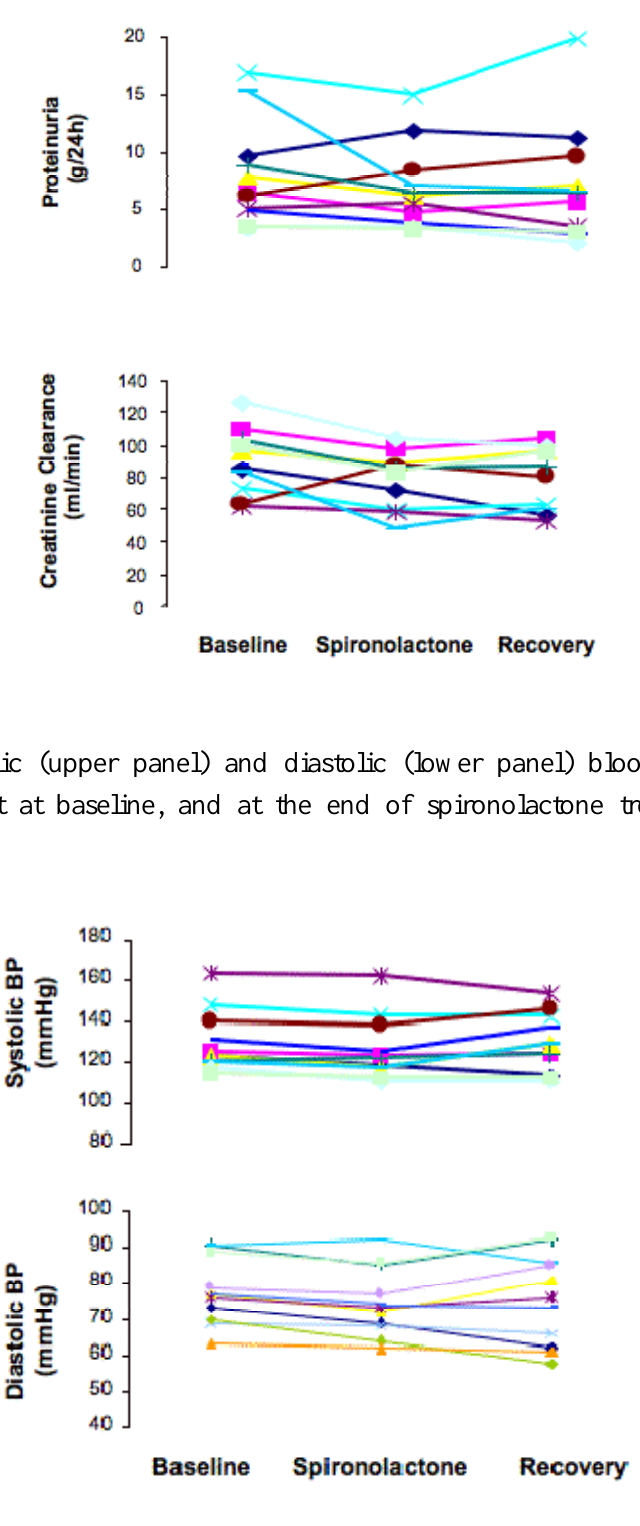
Figure 1. Proteinuria (upper panel) and creatinine clearance (lower panel) in each individual patient at baseline, and at the end of spironolactone treatment and of the recovery period.